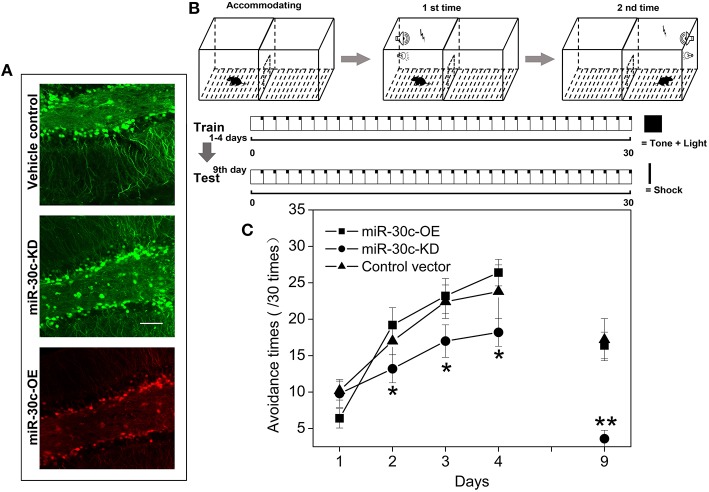
Effect of miR-30c on associative memory. (A) Representative images of miR-30c-OE and miR-30c-KD expression in DG 2 weeks after stereotaxic injection. Scale bar, 50 μm. (B) Schematics of conditional fear memory tests. Thirty cycles in one trial for one mouse each day. Firstly, mouse was accommodating in the test box for 5 min before test. Conditional stumuli (tone and light) gated by computer, were triggered exclusively in the chamber that the mouse stood on. Mouse escaped within 5 s, it would not be shocked, or it would be shocked until it escaped to the other chamber, the maximum shock time is 15 s. Both resulted in the termination of the cycle and the beginning of the next cycle. The total training time was 4 days with an interval of 24 h. Long-term memory test was performed on the 9th day. (C) Time effect on conditional fear memory. *p < 0.05, **p < 0.01 determined by two-way ANOVA analysis followed by Bonferroni multiple comparison tests; n = 15 mice, five mice/group.